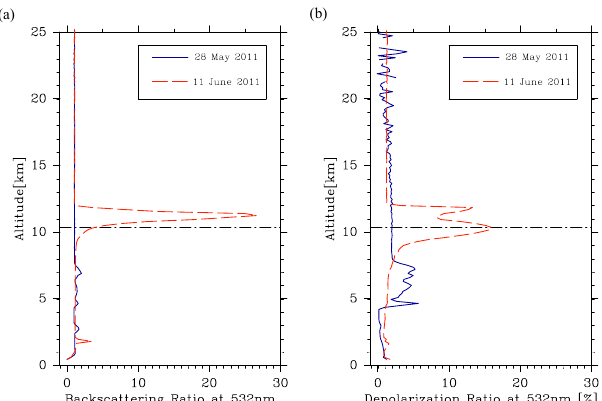
Fig. 1 Figure 1. Vertical profiles of backscattering (left) and depolariza- tion (right) ratios before (28 May, blue line) and after (11 June, red line) the PCCVC eruption on 4 June 2011. The horizontal dot- dash line in each panel shows the tropopause height derived from radiosonde data at